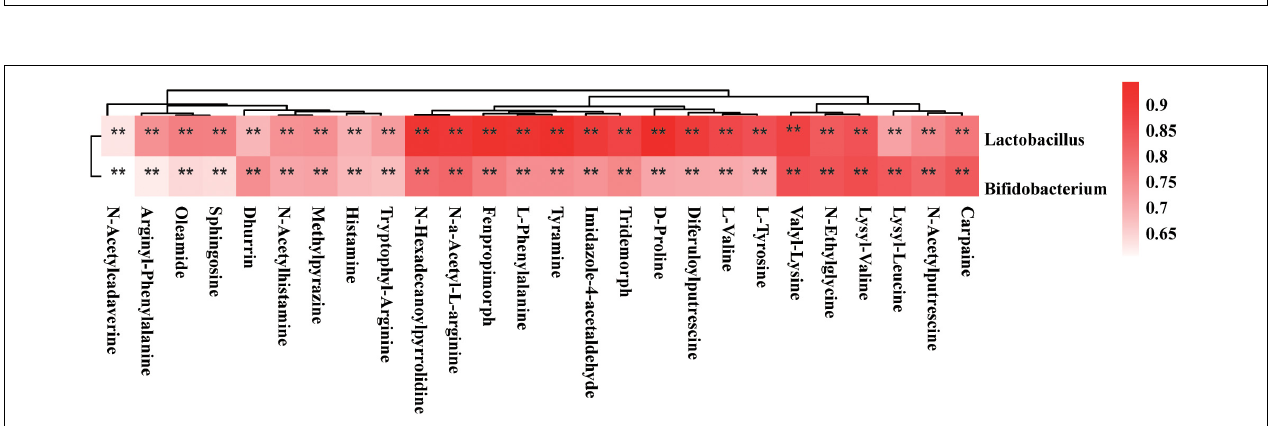
FIGURE 8 | Spearman’s correlation analysis of Lactobacillus and Bifidobacterium genus and metabolites. The r -values were denoted with graduated colors, and red grids indicated positive correlations (* P < 0.05 and ** P < 0.01).